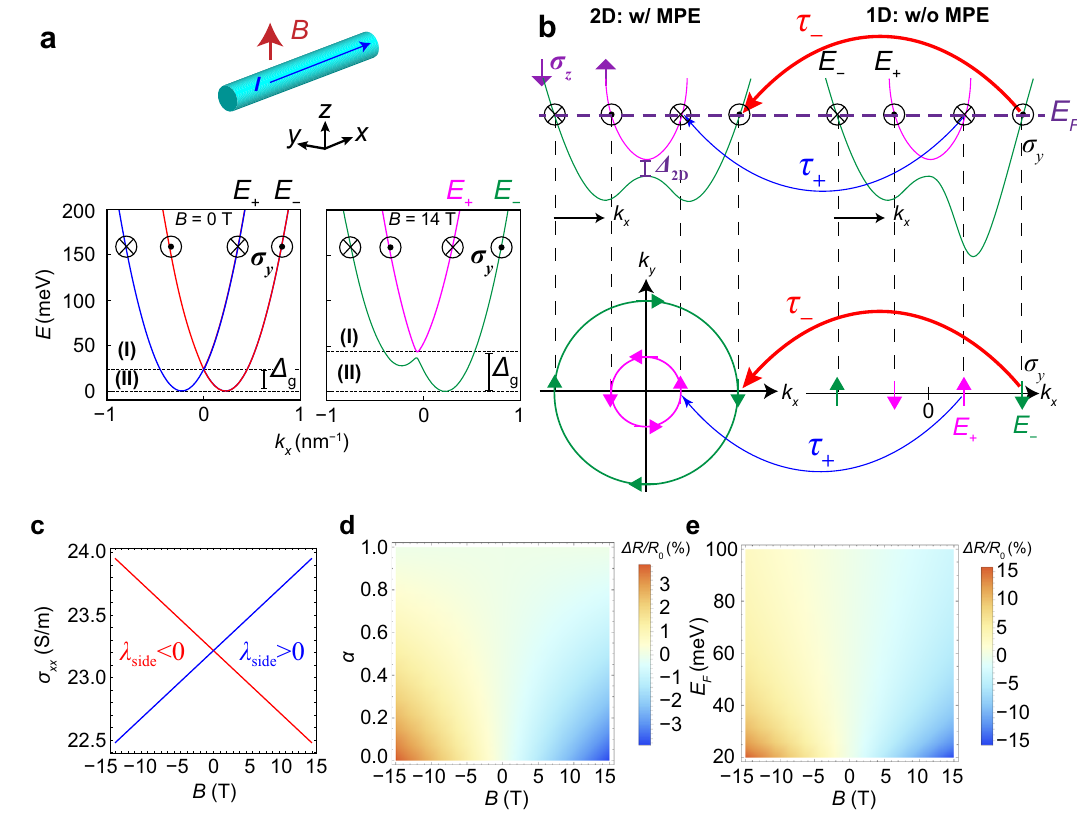
Fig. 4 | Theoretical calculation using Boltzmann ’ s equation in the 1D Rashba systemwithanMPE.a Energy band dispersions ( E + , E − ) of the 1D Rashba system under a magnetic fi eld B (0T and 14T, shown in the left and right panels, respectively) applied parallel to the z -direction, calculated by Eq. (2). Here, we set m */ m 0 =0.08 26 , Δ z / B z =0.52meV/T for g =18 27 , m * λ 2 side =0.45meV 28 , and m * λ 2 top =0.027meV 28 .Inthecaseof B =14T, E + and E − canbelabeledbychirality (pink and green lines, respectively) which is determined by the SIS breaking in the z -direction. Two different regions (I) and (II) can be observed, de fi ned by whether the Fermienergy E F crossesonly oneortwodispersion branches E + and E − . Δ g is the energy gap between the minima of E + and E − . b Schematic energy dispersion (upper) and its Fermi surface (lower) of the 1D (right) and 2D (left) channels. The purple dashed line indicates the Fermi level E F . Due to the Rashba SOI in the z direction in both channels, the y spin component ( σ y ) of electrons is